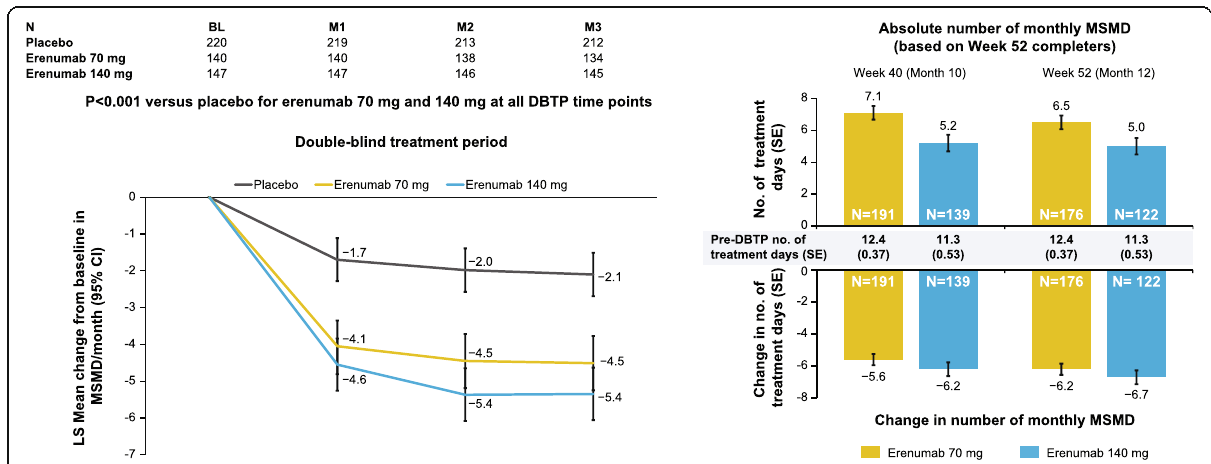
Fig. 3 Change in monthly MSMD over DBTP and OLTP of the CM study in users of MSM at baseline. DBTP results are presented as adjusted means and 95 % CIs utilizing a generalized linear mixed model which includes treatment, visit, treatment by visit interaction, stratification factors region and medication overuse status, and baseline value as covariates and assuming a first-order autoregressive covariance structure. P-values for pairwise comparisons are nominal p-values without multiplicity adjustment. OLTP results are presented as mean ± SE. For patients switching from 70 mg to 140 mg between Weeks 4 and 28 of the OLTP, by Week 40 patients would have been on 140 mg for at least 12 weeks and would have therefore achieved steady state. Consequently, by Week 52, patients would have been on 140 mg for at least 24 weeks. DBTP, double-blind treatment phase; CI, confidence interval; CM, chronic migraine; M, month; MSM, migraine-specific medication; MSMD, migraine-specific medication days; OLTP, open-label treatment phase; SE, standard